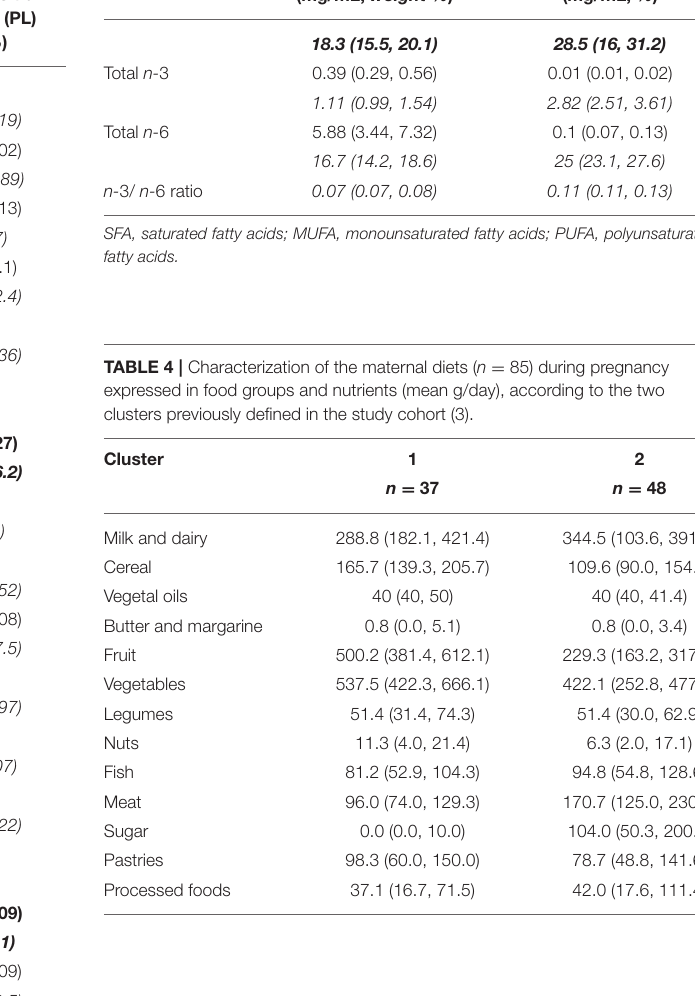
(myristoleic) and C20:3 n-6 (dihomo- γ -linolenic) also showed a positive correlation with nuts intake. A similar pattern as nuts was found in the intake of meat, legumes and vegetables, and a contrasting inverse relationship between these FAs with butter intake. Another relevant observation related to the positive correlation between legumes intake and two relevant n-3 FAs, C18:3 (also detected in vegetables intake), and C20:3 n - 3. As for the group conformed by FAs in PL (C12:0, C14:0, C16:1, C18:2, C22:6, and total n-3 FAs) a cluster of food groups, most of them considered as non-recommendable, showed a negative correlation: sugar, pastries, processed foods, butter, and